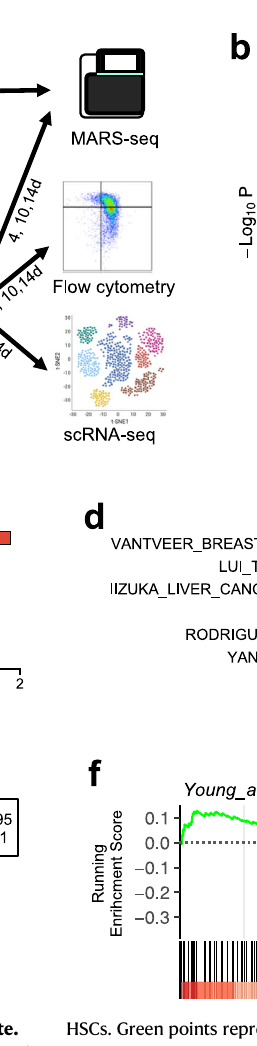
seq data to analyze DDIT3 -induced transcriptional lesions at different stages of erythroid differentiation, from CFU to orthochromatic ery- throblast. DDIT3 -overexpression induced an enrichment in hemato- poietic stemand progenitorcellsignaturesin comparison with control cells(Fig. 5c), aswellasadecreaseintheexpressionof genesrelatedto